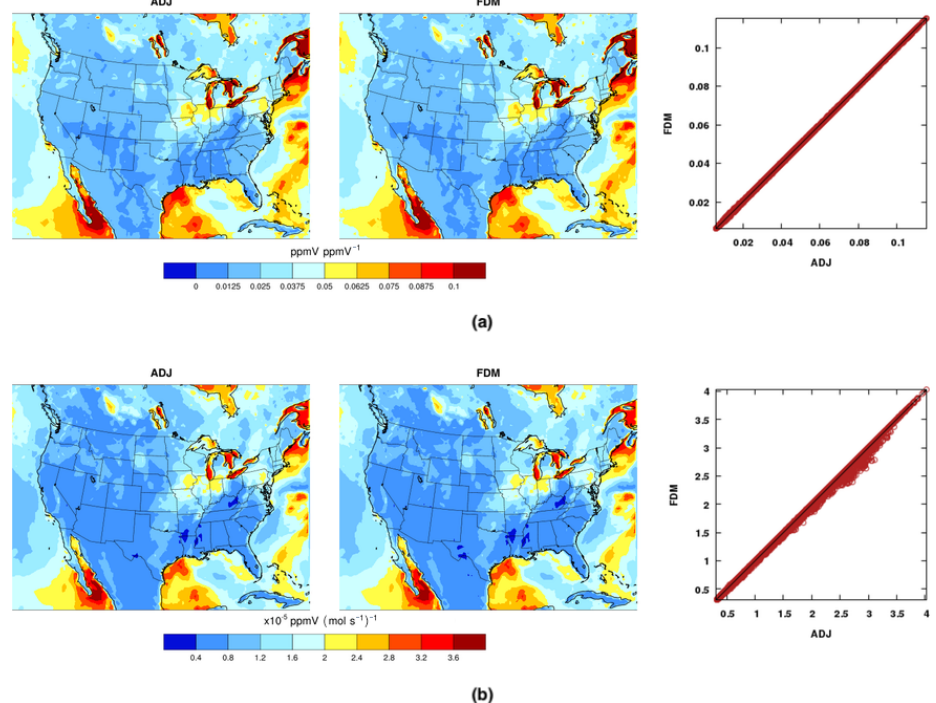
Figure 13. Evaluation of vertical diffusion with the ADJ (adjoint) against the FDM (finite-difference method) from a 1d test run: (a) sensi- tivities of the final ozone (ppmV) with respect to the initial ozone (ppmV) with a 1ppb perturbation size for the FDM; (b) sensitivities of the final nitrogen dioxide (ppmV) with respect to the initial nitrogen dioxide emissions (mols − 1 ) with a perturbation size of 0.1mols − 1 . The values in (b) are multiplied by 10 5 . Table 2. Sizes of checkpoint files for the science processes in CMAQ for a single day. The computational domain has 148 columns, 112 rows, and 24 vertical layers. The synchronization time step of CMAQ is 12min. Shown for horizontal and vertical advections are checkpointing file sizes from the continuous version of the adjoint. Vertical Horizontal Vertical Process Aerosols Clouds Chemistry diffusion advection advection File size (GB) 24 24 17 1 0.2